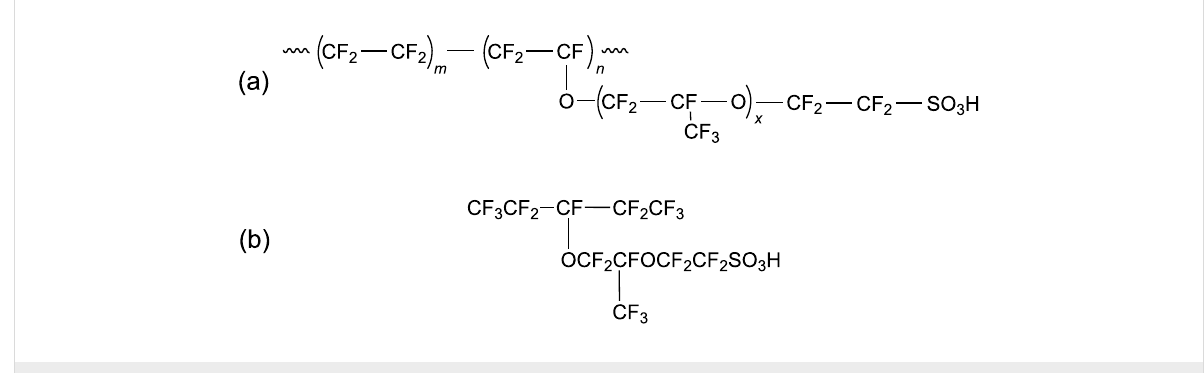
Figure 1: (a) Nafion chain. (b) Nafion sulfonated monomer.